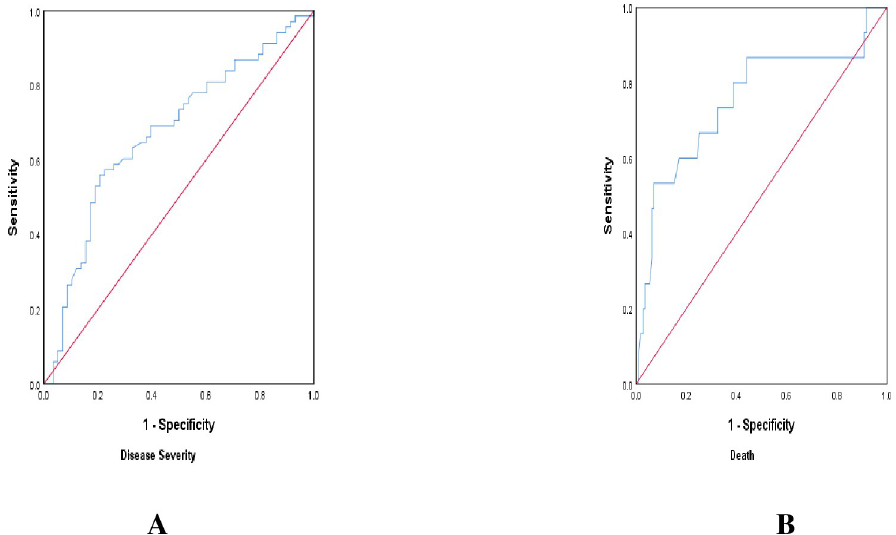
Fig 2. ROC curve analysis to predict NLR as predictor of disease severity (A) and mortality (B).